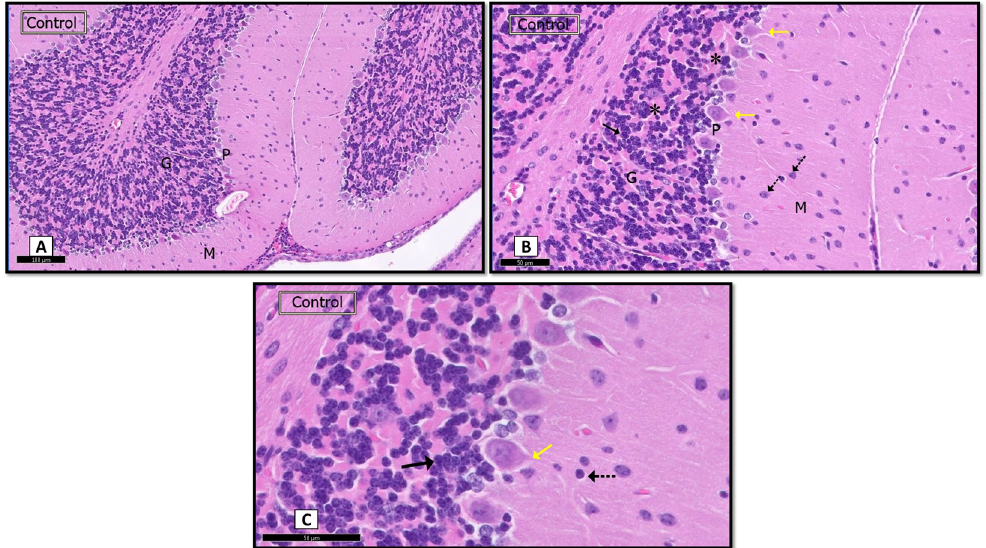
Figure 1. A section of a control rat showing: ( A ) the three layers; molecular (M), Purkinje cell (P), and granular cell layers (G). (H&E. ×10; Scale bar = 100 μ m). ( B , C ): The Purkinje cells (P) in one row. Notice flask-shaped Purkinje cells with apical dendrites (yellow ↑ ), pale stained nuclei, and prominent nucleoli. The granular layer appears consisting of closely packed rounded granule cells with rounded pale vesicular nuclei (Black arrow). Notice molecular layer (M) shows many glial cells (dot ↑ ) and the spaces of cerebellar islands (*). (H&E. B × 20, C × 40; Scale bar = 50 μ m).